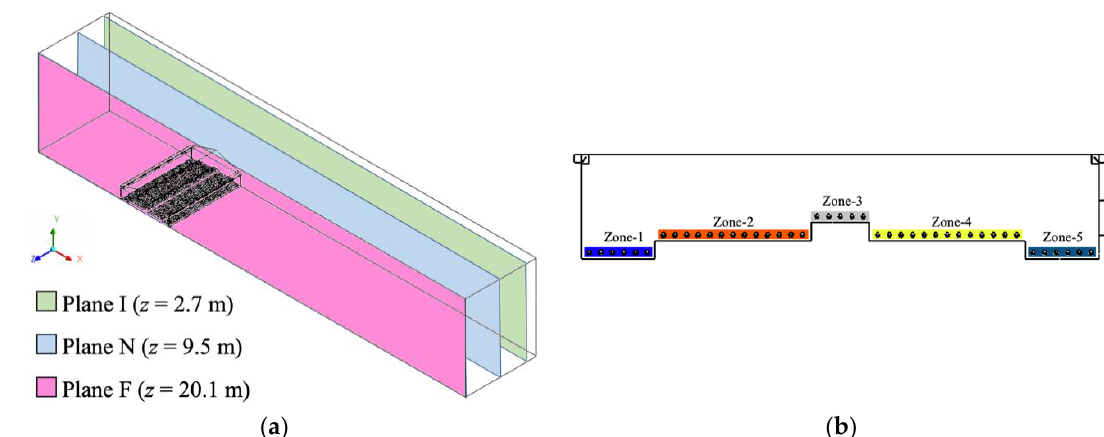
Figure 4. Important locations are shown for data processing and analysis at: ( a ) three designated two-dimensional planes; ( b ) front view of five hen-occupied zones (Plane I, TISE).